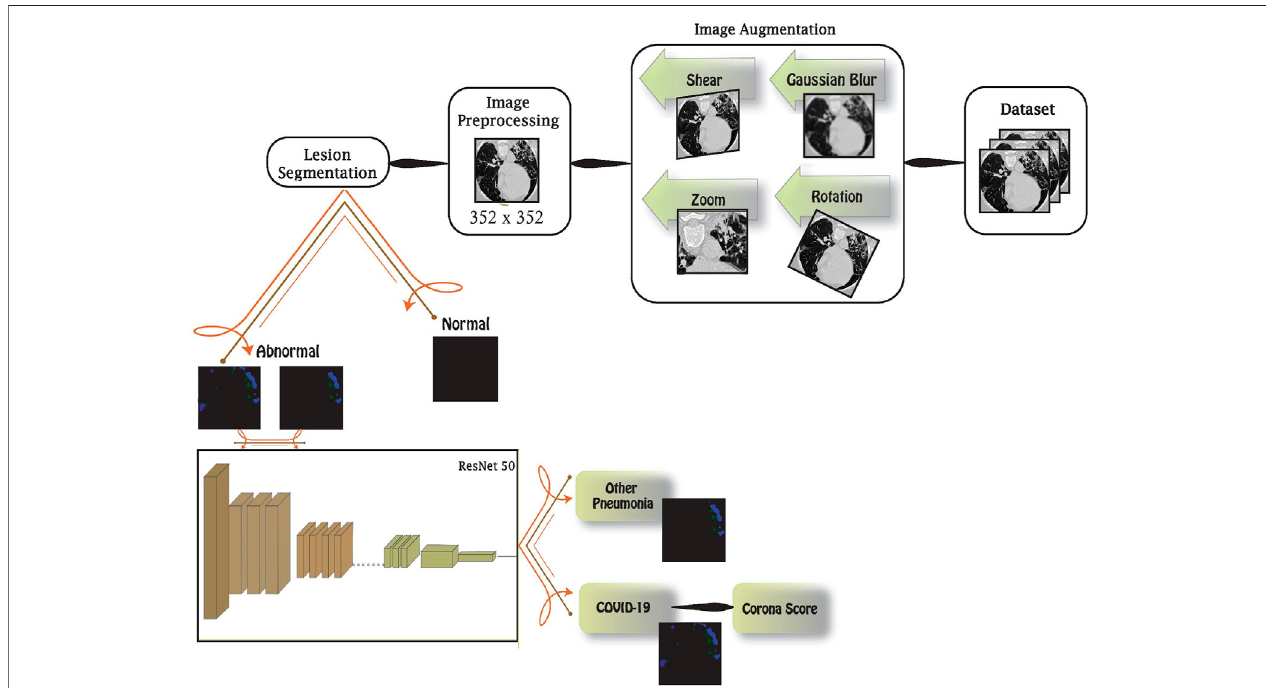
FIGURE 1 | Block diagram of the proposed